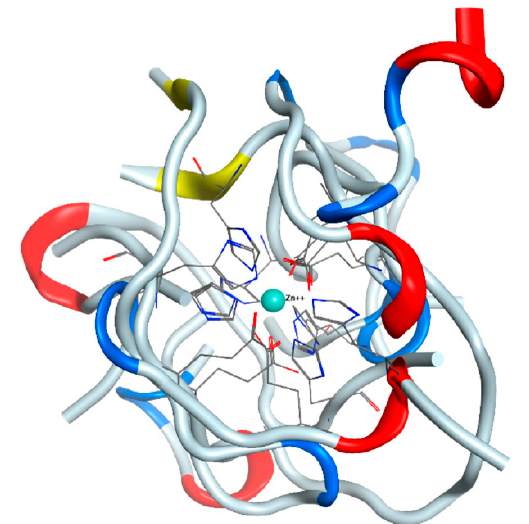
Figure 1. Results of the 100 ns MD simulations of the A β 16 dimer after zinc ion was shifted away from the coordination center. Four final structures are superposed and centered around zinc ion. Zinc coordinating residues are shown.